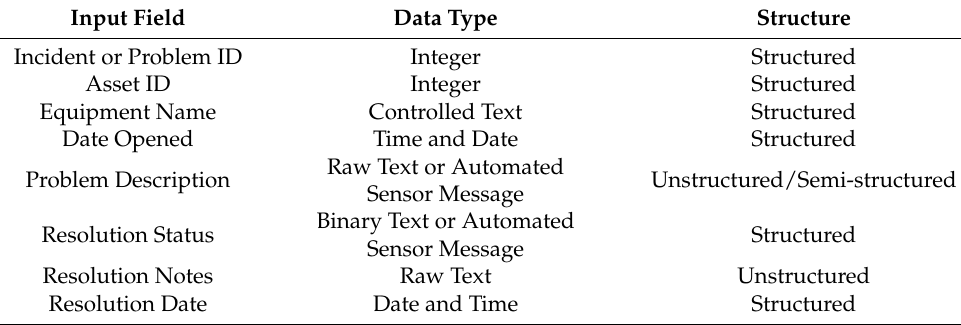
Table 1. Example of typical maintenance log data entry fields.